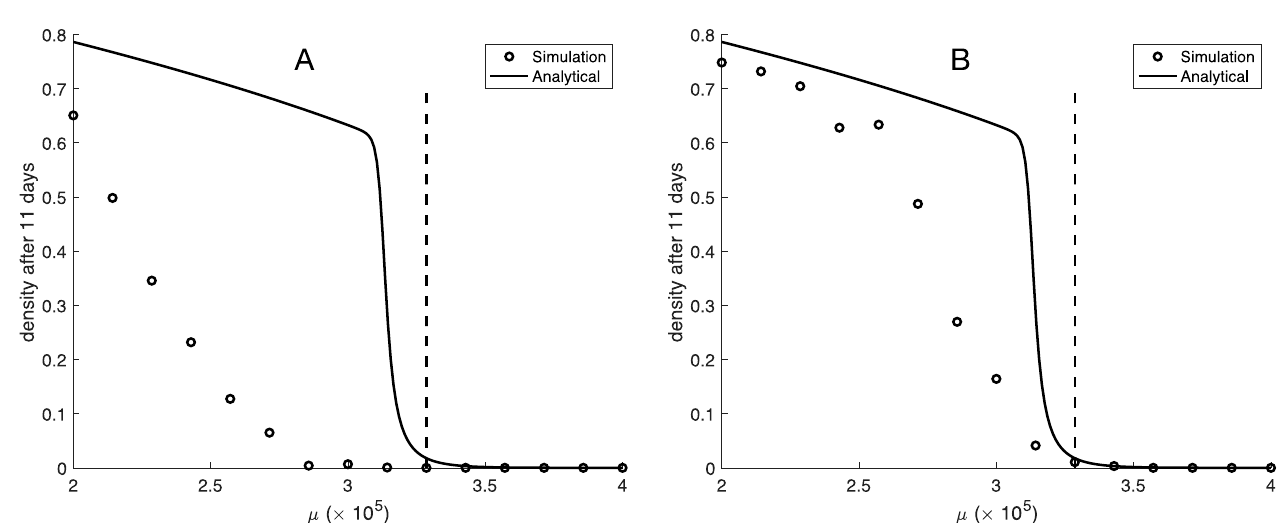
Fig 4. The population density after 11 days as a function of the death rate μ . Results from the IB-model (circles) and the numerical solution of (3) (solid line) under (A) short range dispersal and no cell migration and (B) short range dispersal and a cellular diffusion coefficient of D parameter values are given in Table 1.